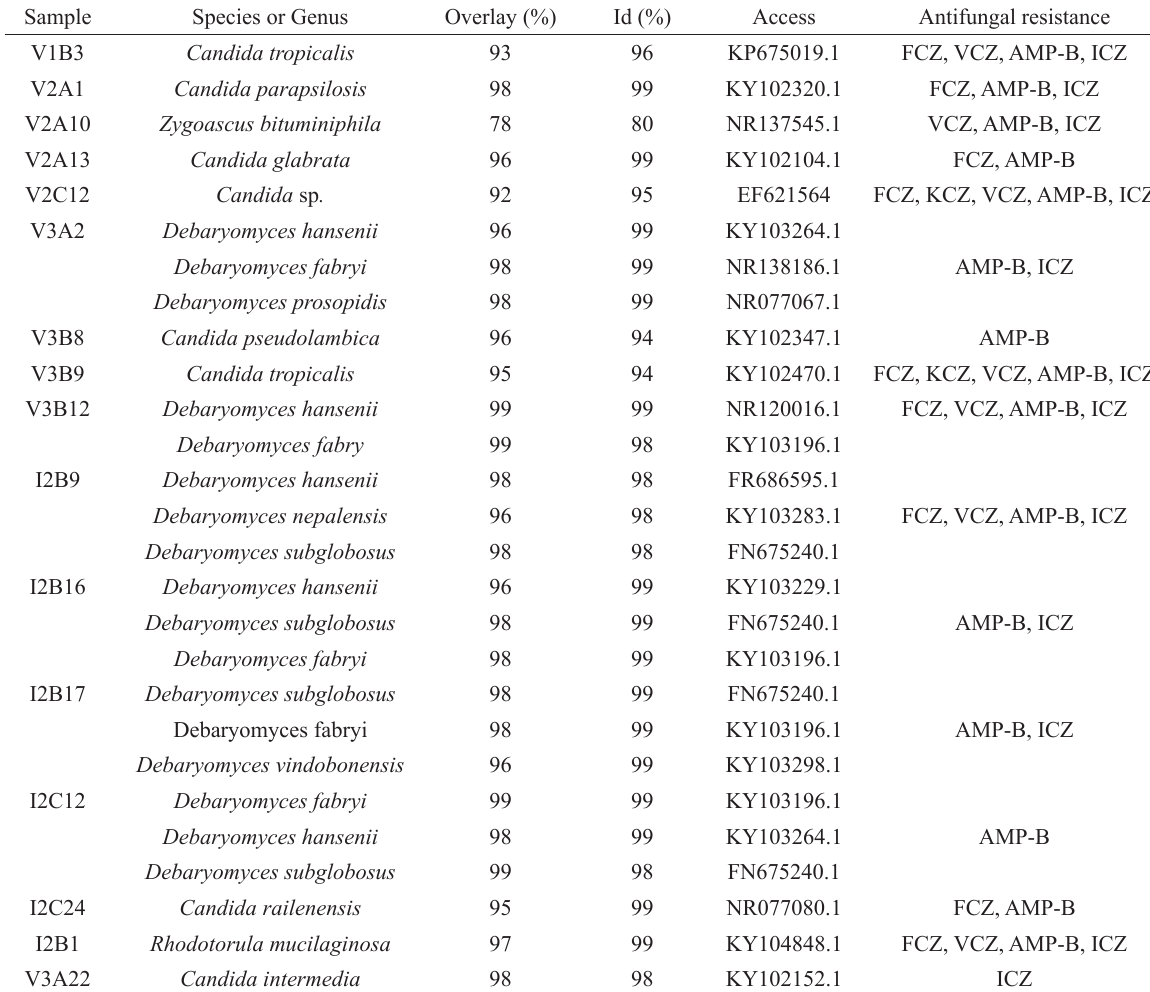
Isolates submitted to sequencing and their species or genera, sequence identity values (Id), overlay and accession number in database and the antifungals in which they presented resistance. FCZ = Fluconazole, KCZ = Ketoconazole, VCZ= Voriconazole, AMP-B = Amphotericin B, ICZ=